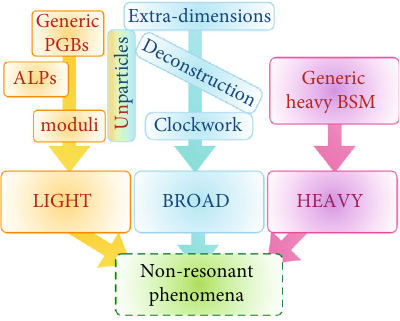
Figure 2: Schematic view of models of nonresonant behaviour.